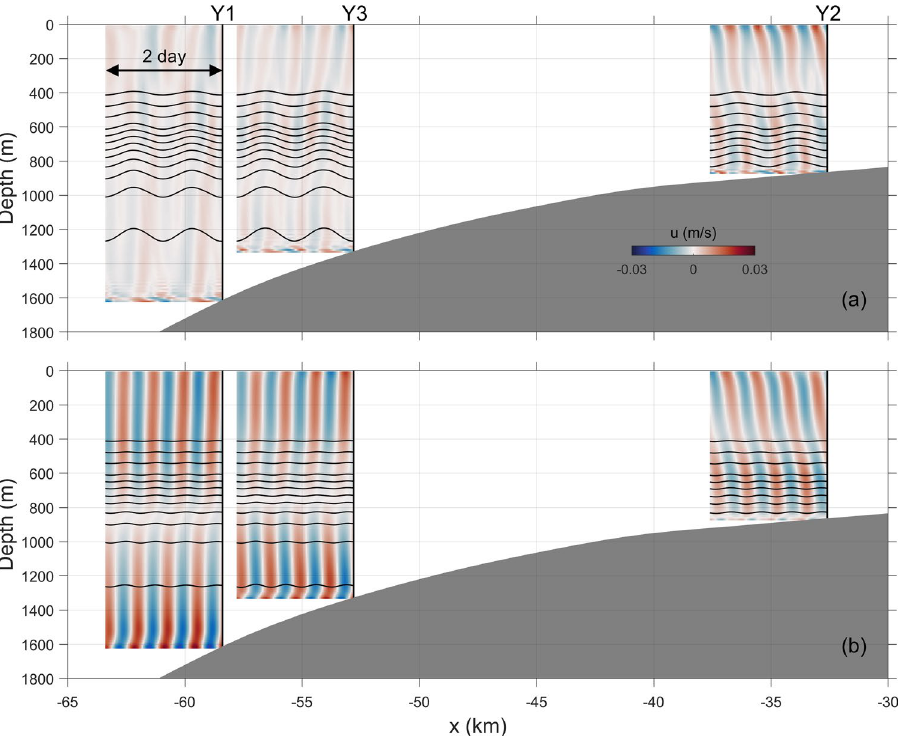
Figure 8. Time series of cross-shore baroclinic currents (shadings, unit: m/s) and isotherms (contours, unit: °C) at mooring locations for runs ( a ) K1A and ( b )